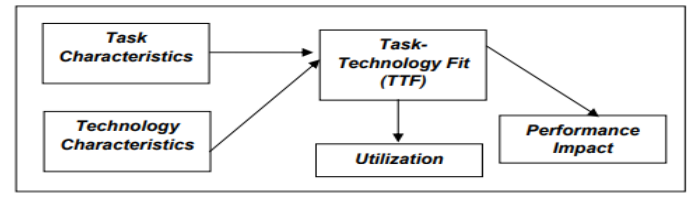
Figure 1: Model Task-Technology Fit